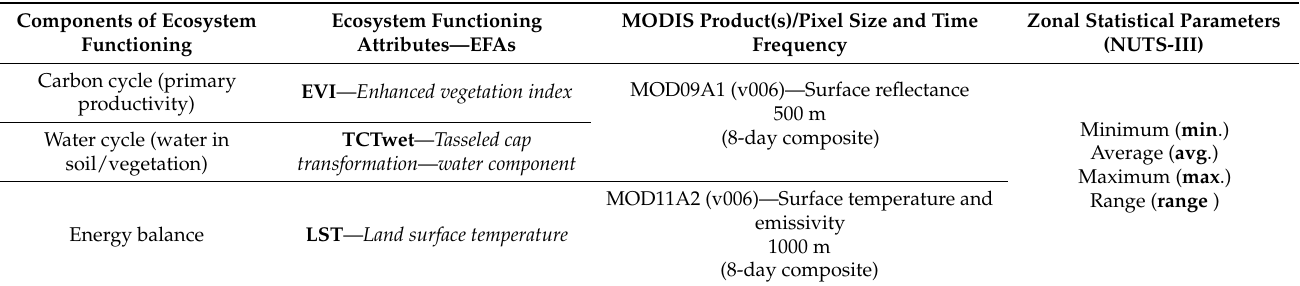
Table 1. List of variables estimated from the Terra/MODIS satellite imaging products. For the list of acronyms of the remote sensed ecosystem functioning variables, see Table